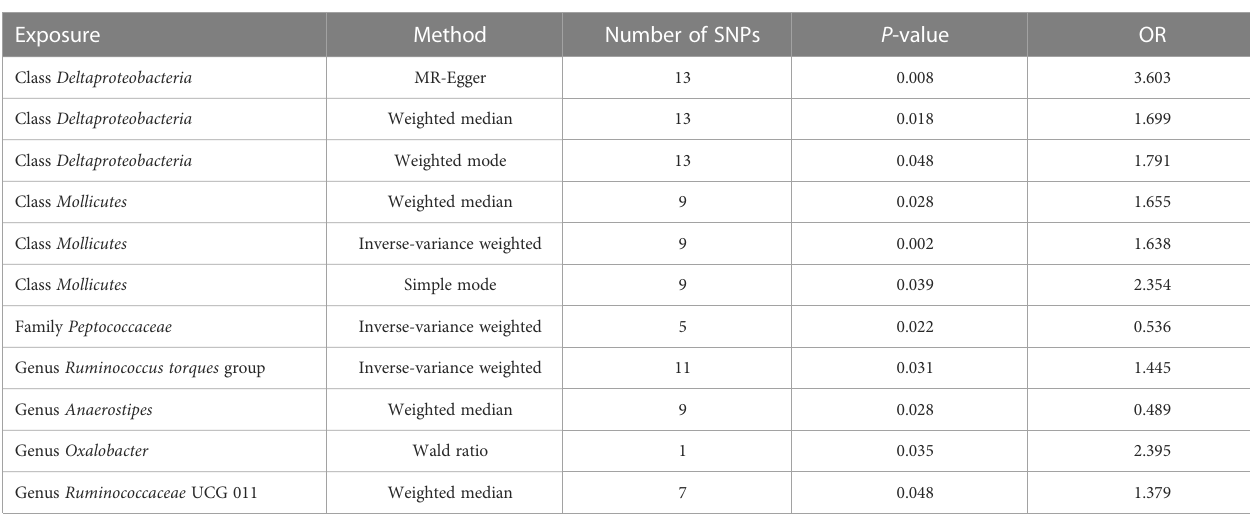
TABLE 2 Causal effects of the gut microbiome on Graves ’ disease (GD).